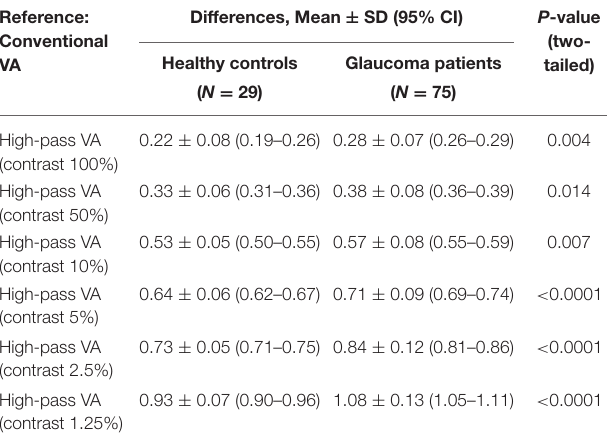
TABLE 3 | Differences in visual acuities measured using conventional chart and high-pass charts in glaucoma patients with normal vision ( N = 75) and the healthy controls ( N = 29). ( Figure 6 ). In addition, the optimal cutoff point of each VA test was obtained from the Youden index with the best sensitivity- specificity balance ( Table 4